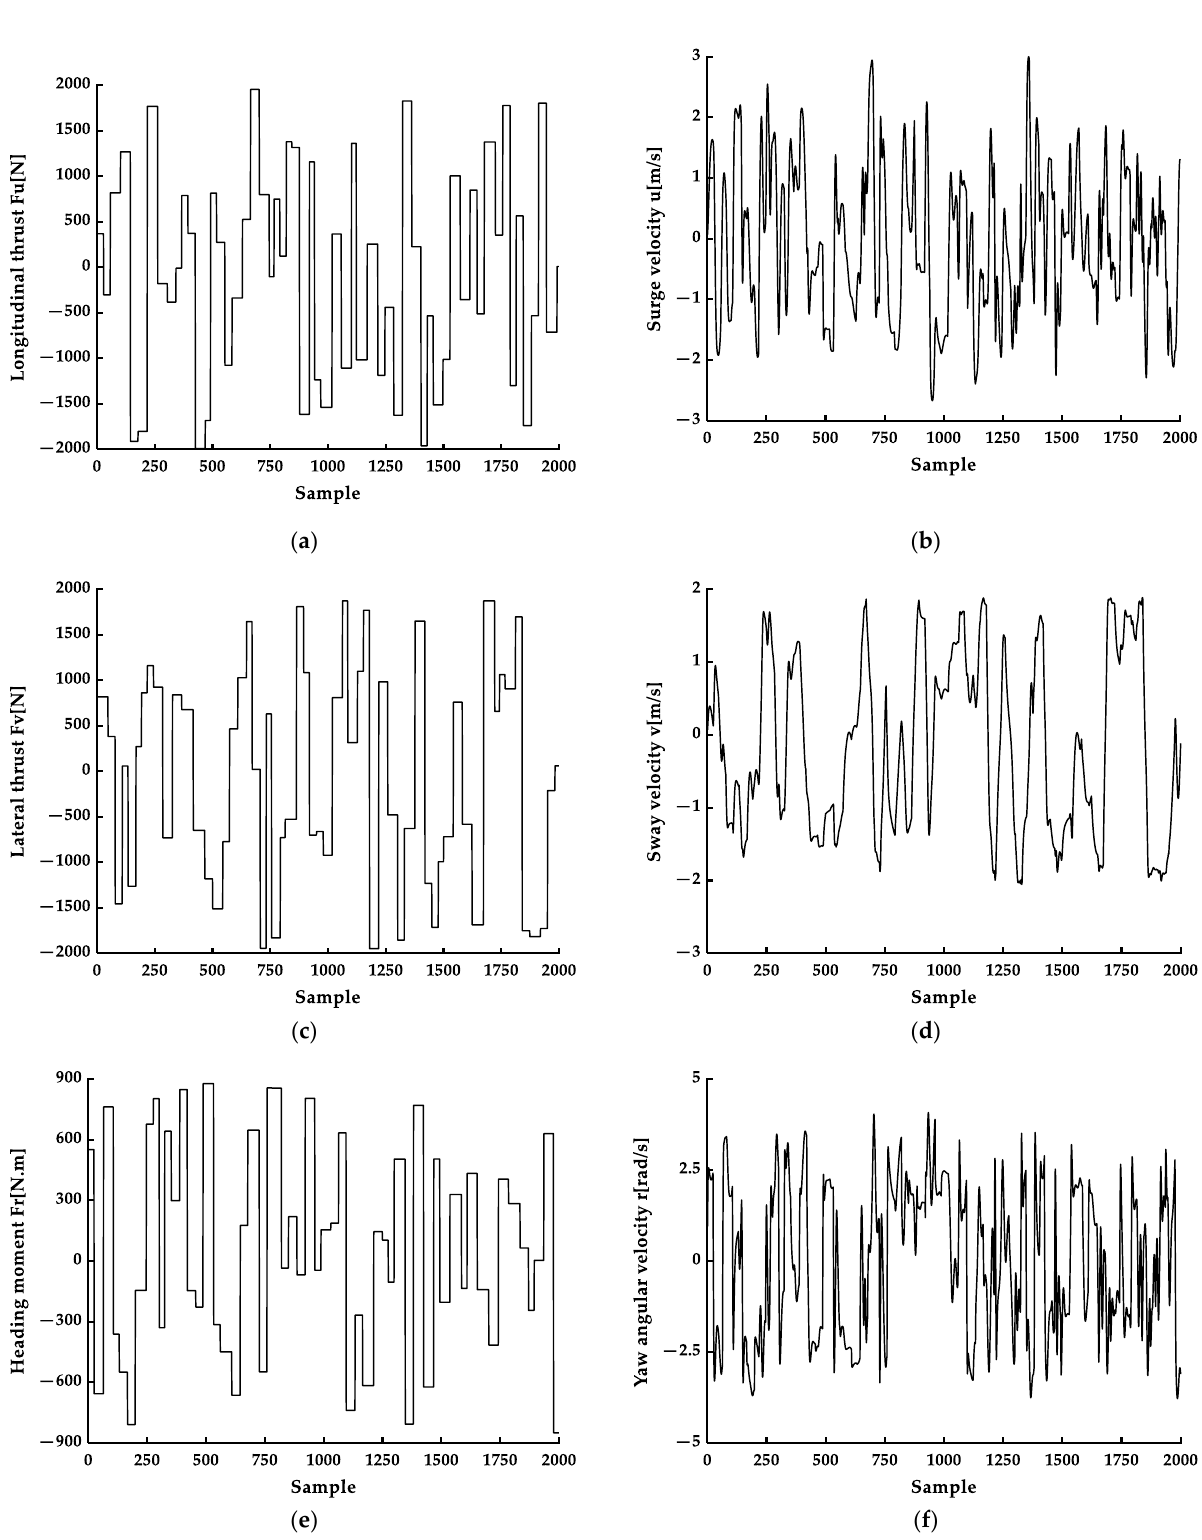
Figure 3. The sets of input and output data for dynamic system identification: ( a ) The excitation signal of longitudinal thrust; ( b ) The response signal of surge velocity; ( c ) The excitation signal of lateral thrust; ( d ) The response signal of sway velocity;( e ) The excitation signal of heading moment; ( f ) The response signal of yaw angular velocity.